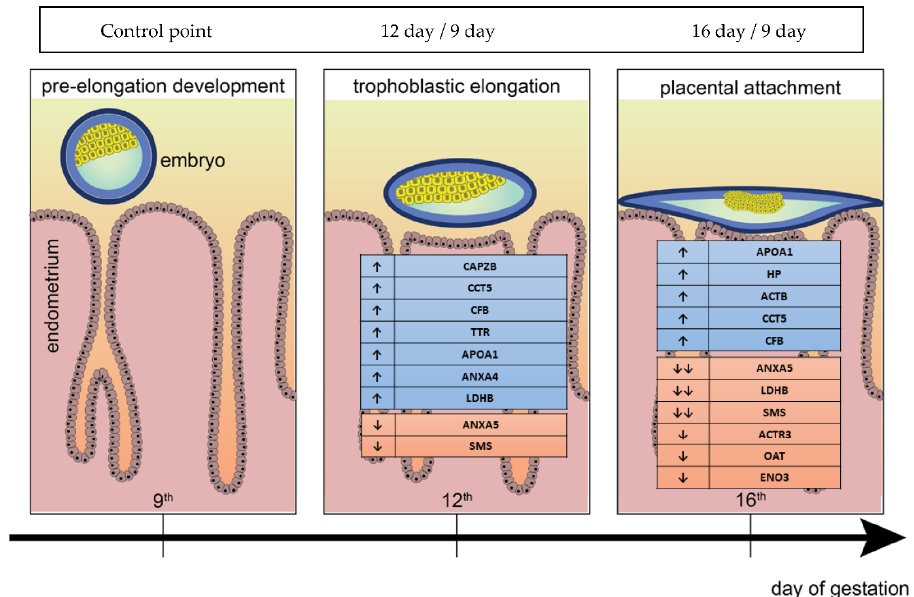
Figure 2. Graphical visualisation of identified DEPs between the preimplantation and peri-implantation periods using two-dimensional electrophoresis (2DE) coupled with MALDI TOF/TOF. Arrow indicating the upregulated and downregulated altered protein abundance. ↑ — increase protein expression in 12th or 16th day in comparison to 9th day; ↓ — decrease protein expression in 12th or 16th day in comparison to 9th day; down arrows ( → ) means time line of stages of early pregnancy in PLW gilts.